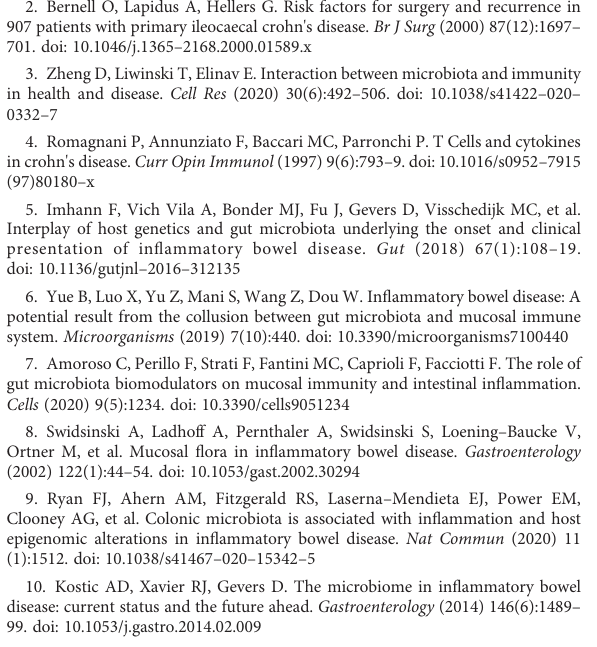
SUPPLEMENTARY FIGURE 1 Box-plots showing alpha diversity indices (Chao1 index, Shannon index, Evenness) in CD and healthy samples. Statistical differences were evaluated using paired Wilcoxon signed-rank test for Chao, Shannon and Evenness indices. P-values less than 0.05 were considered statistically signi fi cant. SUPPLEMENTARY FIGURE 2 Taxonomic composition of paraf fi n-embedded ileal samples in ileal and CD tissue. The stacked bar plot shows the relative abundance of the fi ve more abundant bacterial genus in each sample, The “ Others ” group contains genus with ranks below fi ve. SUPPLEMENTARY FIGURE 3 Box-plots reporting alpha diversity indices (Chao1, Shannon and Eveness index) in fi rst surgery and relapse patients, for both CD (A) and Healthy tissues (B) . P-values less than 0.05 were considered statistically signi fi cant. SUPPLEMENTARY FIGURE 4 Principal Coordinate Analysis using Bray-Curtis dissimilarity as a distance metric on square root transformed percent abundance of identi fi ed OTUs showingpermutedp-valueofgeneral b dispersionandpairwise b dispersionof CD andhealthy groups. The lines connect the samplesfromthe same